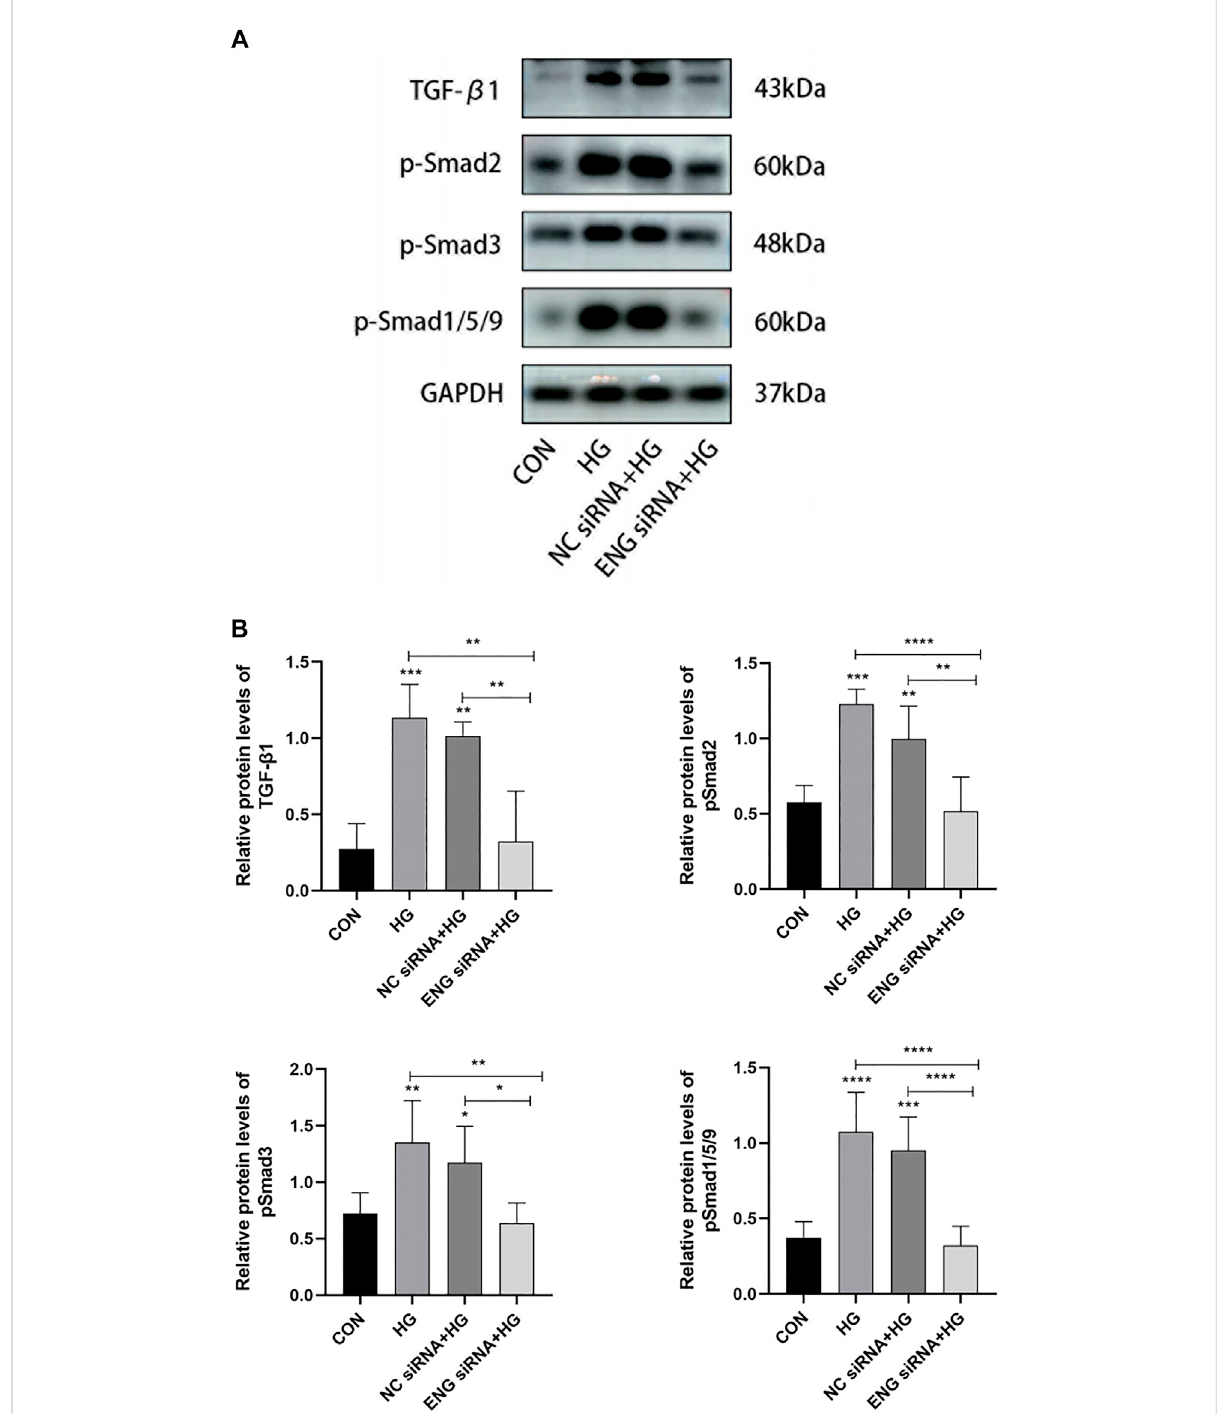
FIGURE 7 Endoglin de fi ciency inhibited the TGF- β /ALK/Smads pathway involved in HG-induced HPMCs injury. (A) Western blot analysis of TGF- β 1, p-Smad2,p-Smad3andp-Smad1/5/9proteinlevelsindifferentgroupsofHPMCs.Theresultsfromthequantitativeanalysisareshownin (B) .Dataare shown as mean ± SD, * p < 0.05, ** p < 0.01, *** p < 0.001, **** p <